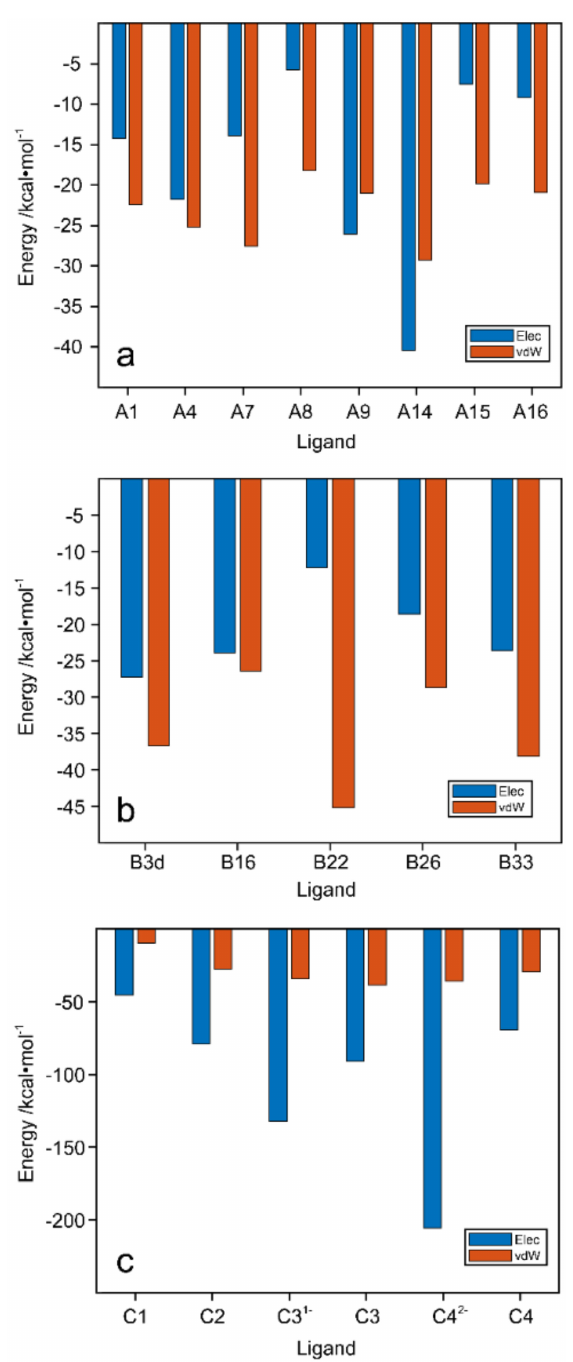
Figure 7. Contributions of electrostatic and van der Waals interactions to the binding of ( a ) library A, ( b ) library B and ( c ) library C ligands to WaaG binding pocket. Elec = electrostatic; vdW = van der